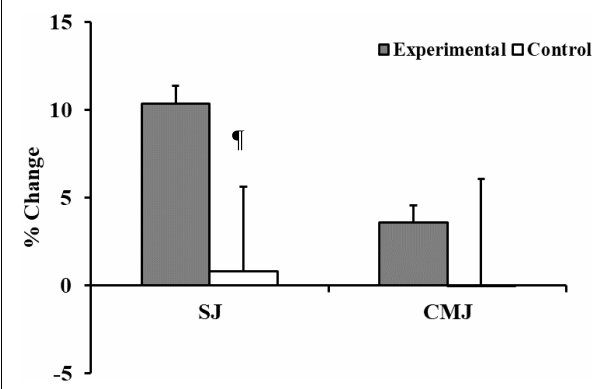
FIGURE 3 | Training associated changes in vertical jump performances (SJ, Squat jump; CMJ, Counter Movement Jump) in experimental and control groups. ¶ANOVA: A two-way analysis of variance (group × time) assessed the statistical significance of training-related effects: p <